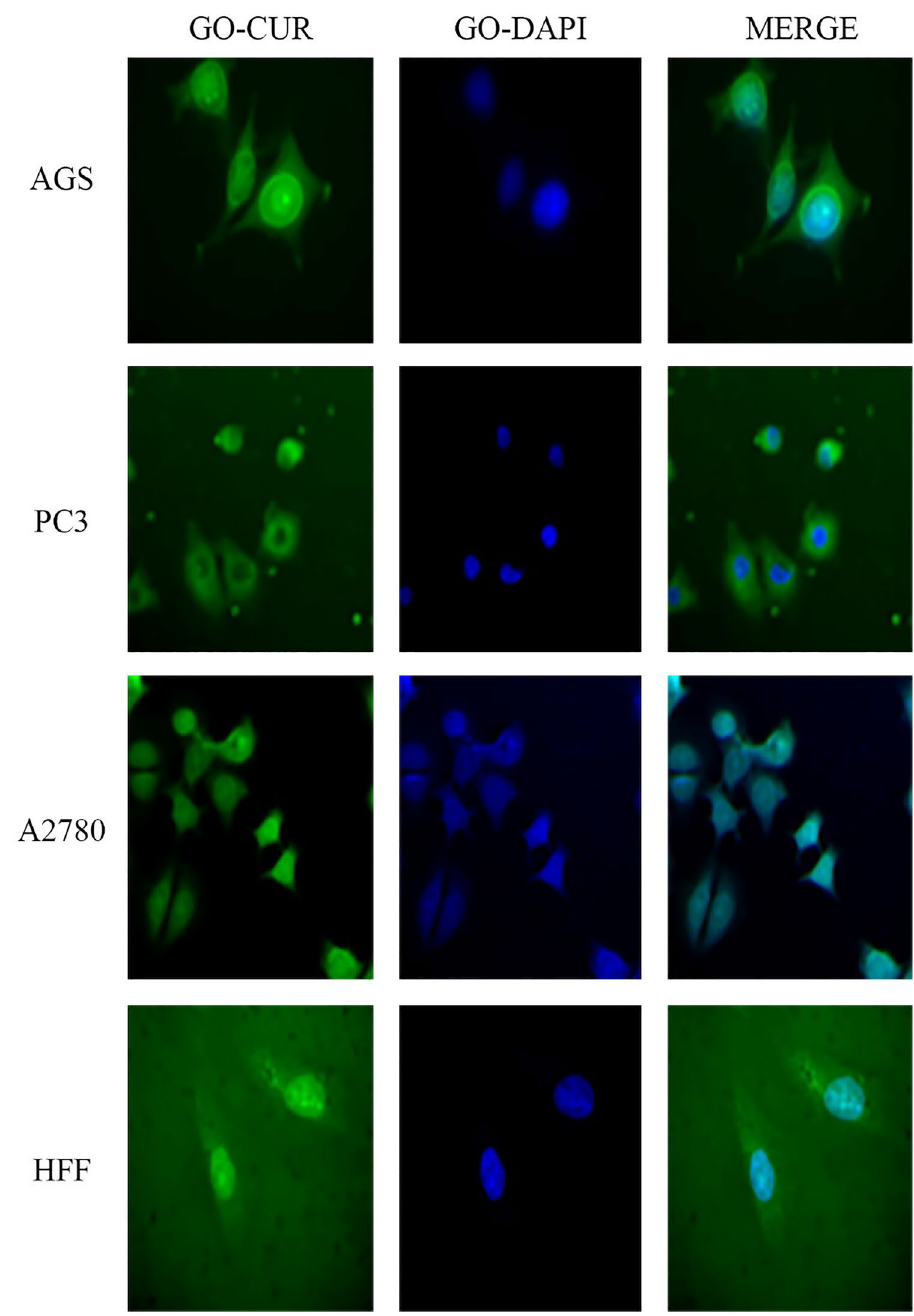
Figure 7. Cellular uptake images of AGS, PC3, A2780 and HFF cells incubated with GO-CUR for 180